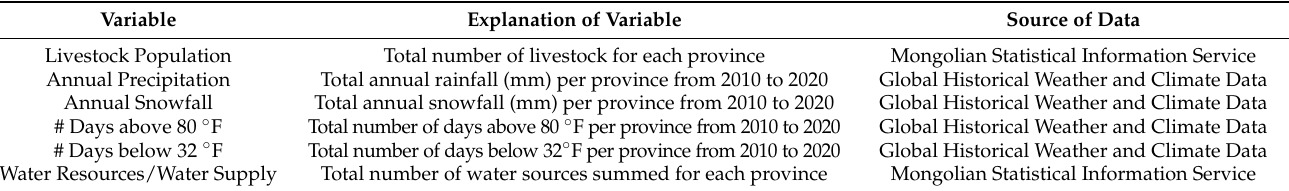
Table 1. Dependent variables and their sources.